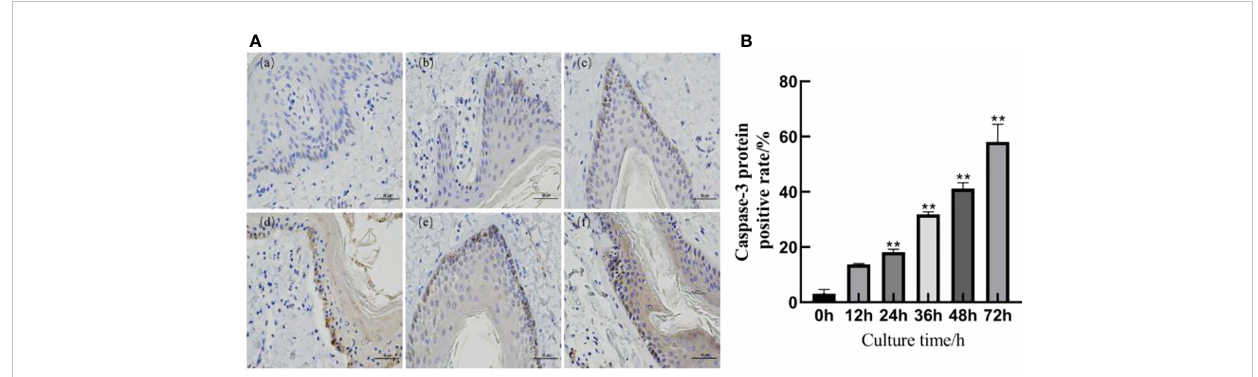
FIGURE 3 Apoptosis of intertoe explants infected with F. necrophorum over 72 h. (A) TUNEL staining images of intertoe skin explants infected with F. necrophorum over 72 h. (A) Skin explants infected with F. necrophorum for 0 h, (B) 12 h, (C) 24 h, (D) 36 h, (E) 48 h, and (F) 72 h. TUNEL stained apoptotic cells are brown, and hematoxylin and eosin stained nuclei are blue. (Scale bar = 50 µm). (B) Statistical analysis of the apoptosis rate of skin explants. The data presented are the mean ± SD. *statistical signi fi cance (P < 0.05). **statistical signi fi cance (P < 0.01). The symbols * and ** indicate the signi fi cant differences with the control